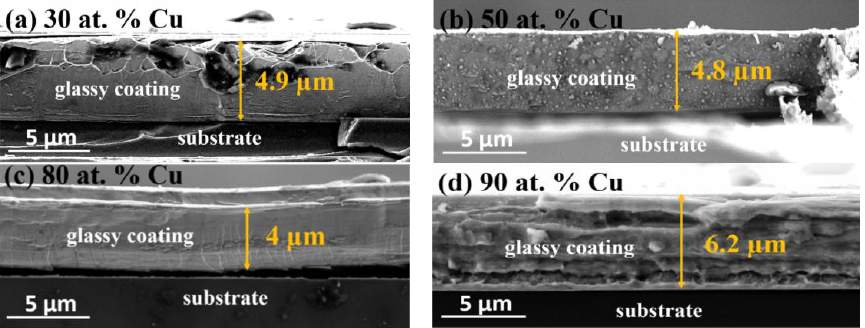
Figure 2. Scanning electron microscopy (SEM) images of cross sections of Zr-Cu glassy coatings.